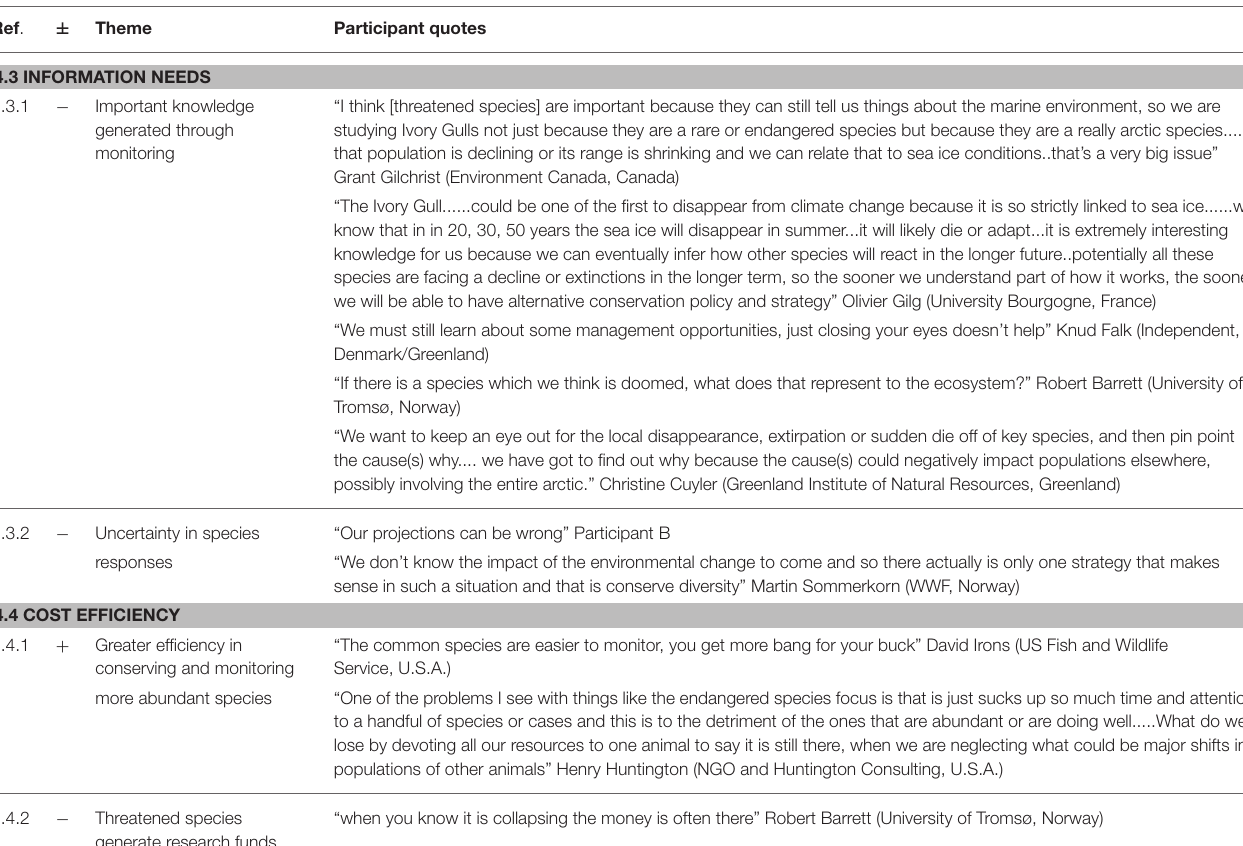
TABLE 3 | Summary of stakeholder perspectives relating to information needs and cost efficiency in relation to triage in wildlife monitoring in the arctic. Ref